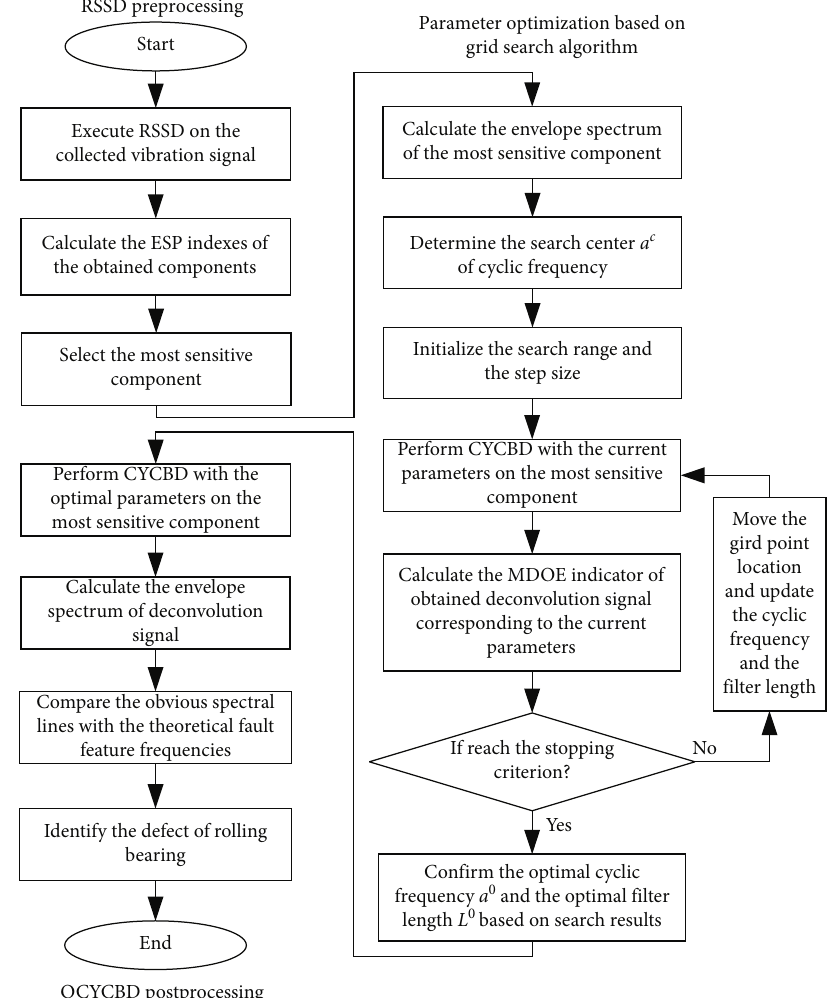
Figure 5: Implementation procedures of proposed diagnosis